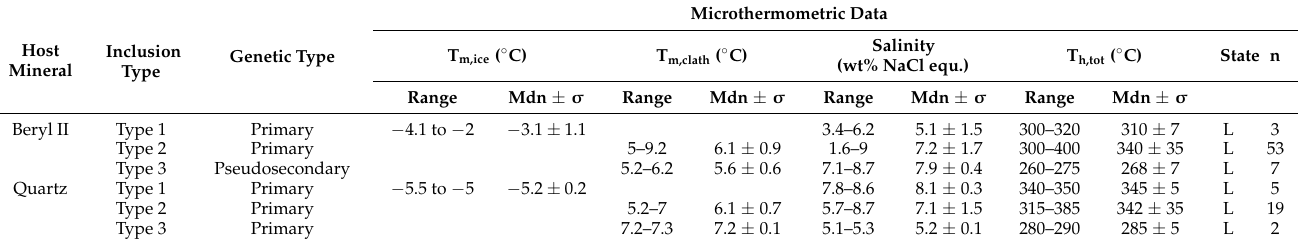
Table 3. Summary of inclusion types from the Dakalasu No.1 Pegmatite.